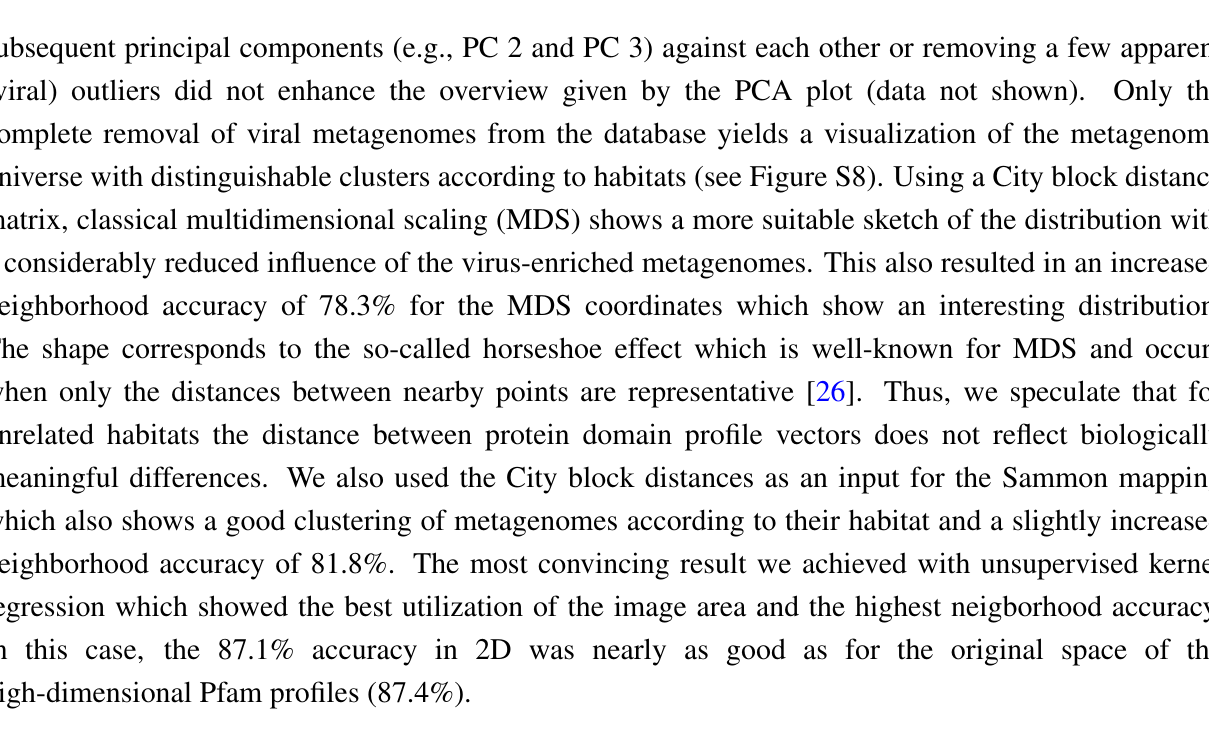
Figure 3. 2D representation of metagenome universe for different dimension reduction methods using UProC protein domain profile space. Markers represent